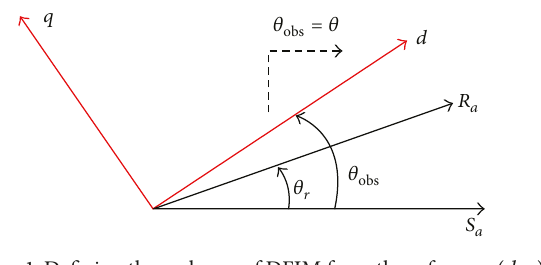
Figure 1: Defining the real axes of DFIM from the reference ( 𝑑,𝑞